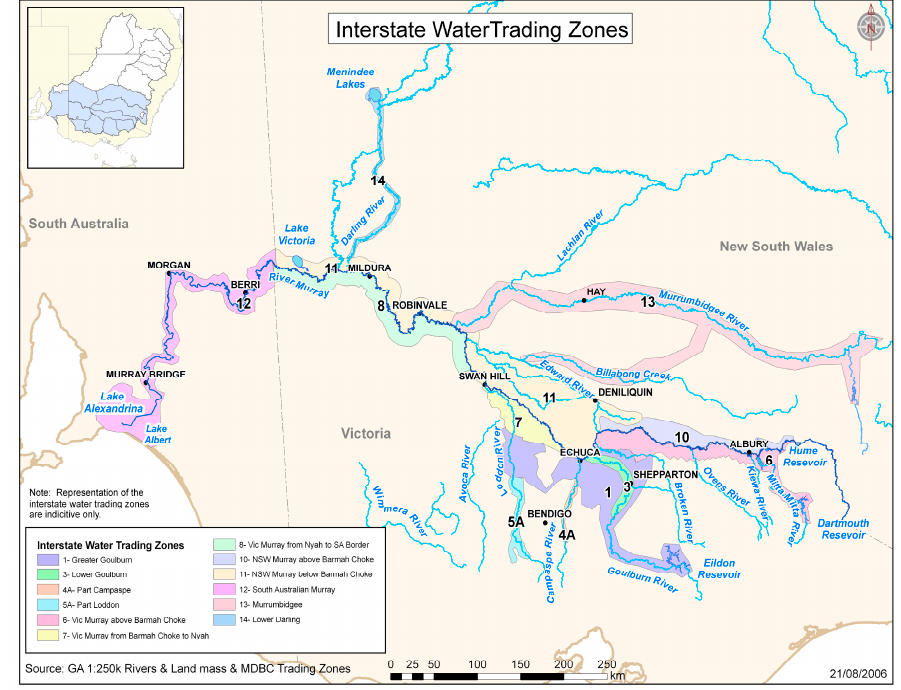
Figure 4. Map of the Murray Darling Basin Southern Basin interstate water trading zones [59].